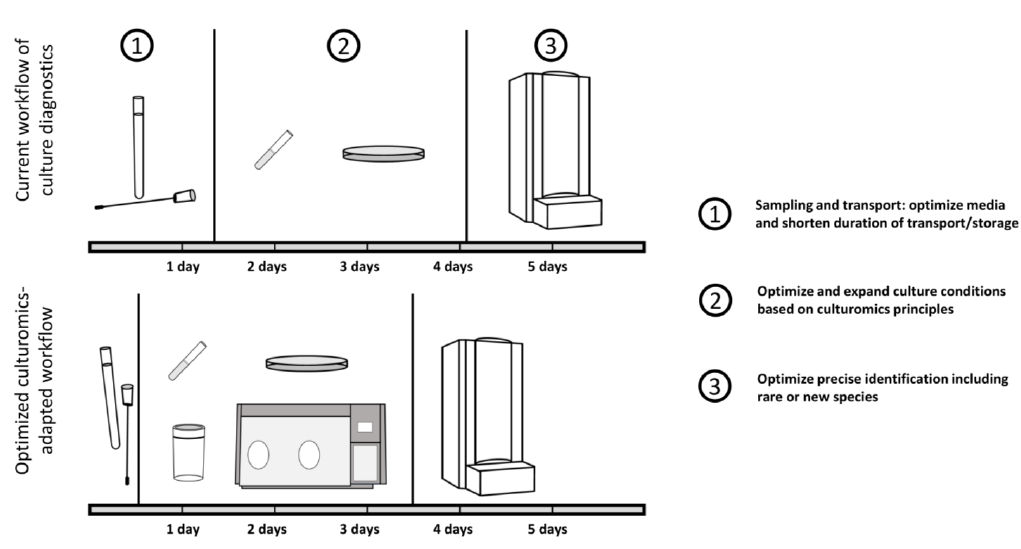
Figure 1. Schematic workflow of routine diagnostics with suggestions for optimization. Current routine diagnostics are suffering from a prolonged duration from sampling to cultivation, with culture conditions enabling only a limited number of microbes to be identified.